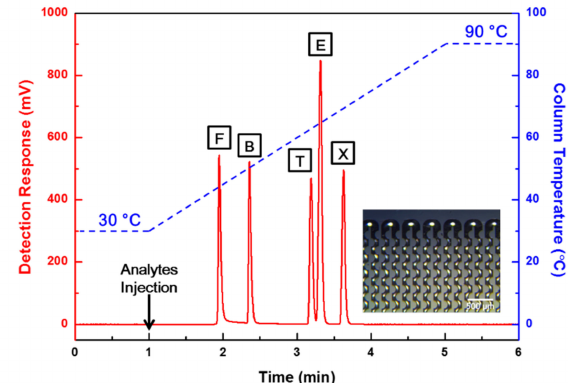
Figure 7. Chromatograms of the separation result obtained through the bump structure µ -GC column proposed in this study. The temperature of the µ -GC column was maintained at 30 ◦ C for 1 min, ramped to 90 ◦ C at a ramping rate of 15 ◦ C / min, and then maintained at 90 ◦ C for 1 min. The temperature programmingofthecolumnwasperformedbymicro-heatersandRTSofthe µ -GCcolumn. Fivedi ff erent peaks were completely separated in the